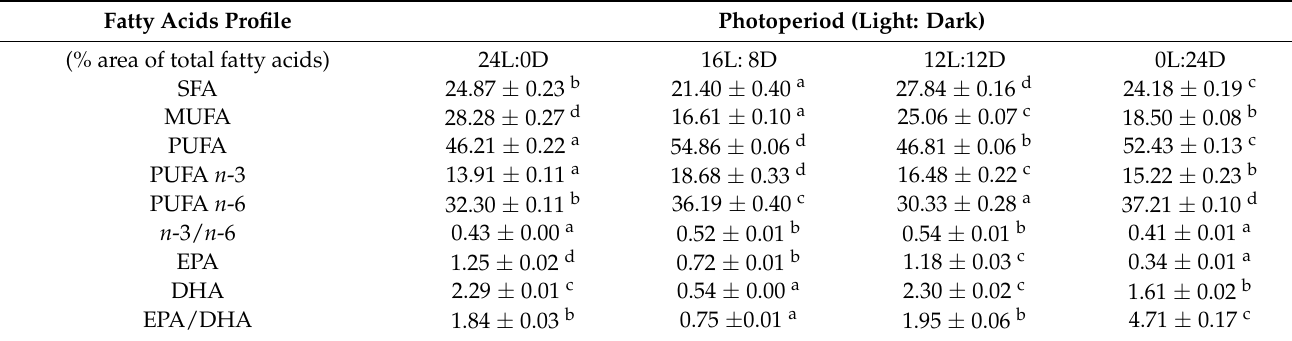
Different superscript letters within each row indicate statistically significant differences at p < 0.05. Saturated fatty acid (SFA), Monounsatu- rated fatty acids (MUFAs), Polyunsaturated fatty acids (PUFAs), Eicosapentaenoic acid (EPA) and Docosahexaenoic acid